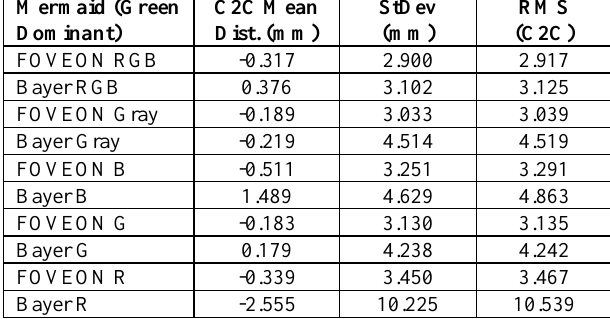
Table 5: Mean Distance, Standard Deviation and RMS error of every point cloud from the reference point cloud for Mermaid graffiti.